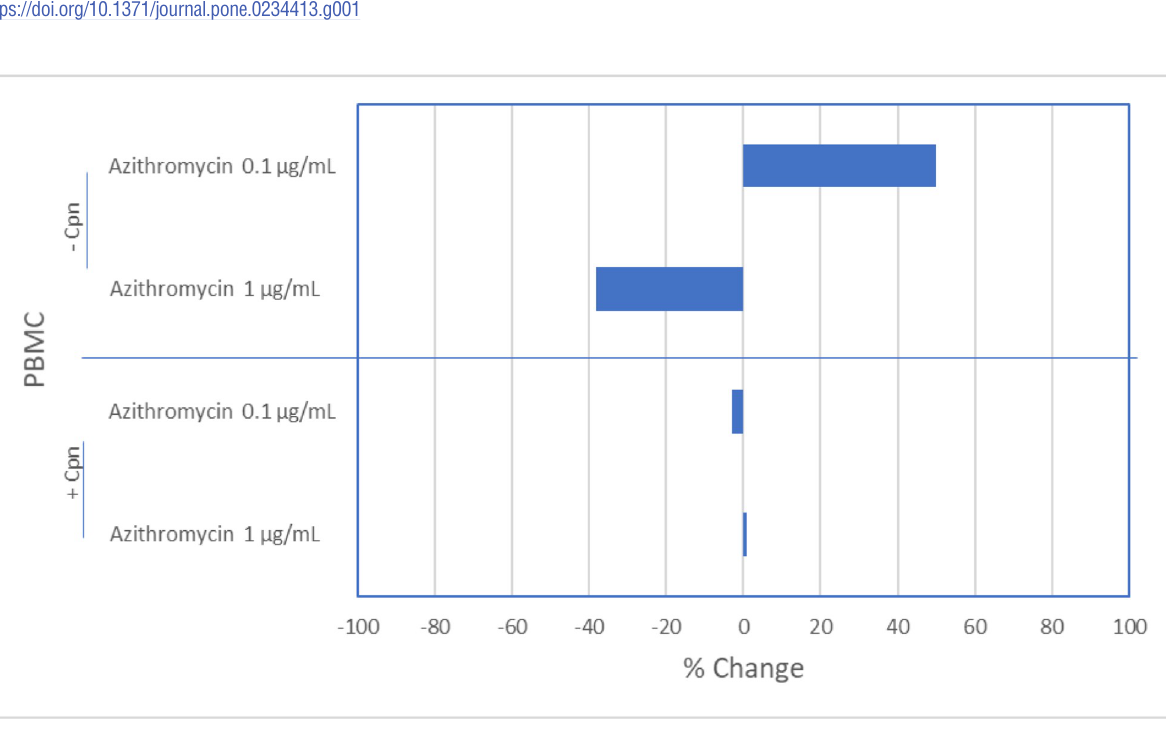
PLOS ONE | https://doi.org/10.1371/journal.pone.0234413 June 8, 2020 5 /